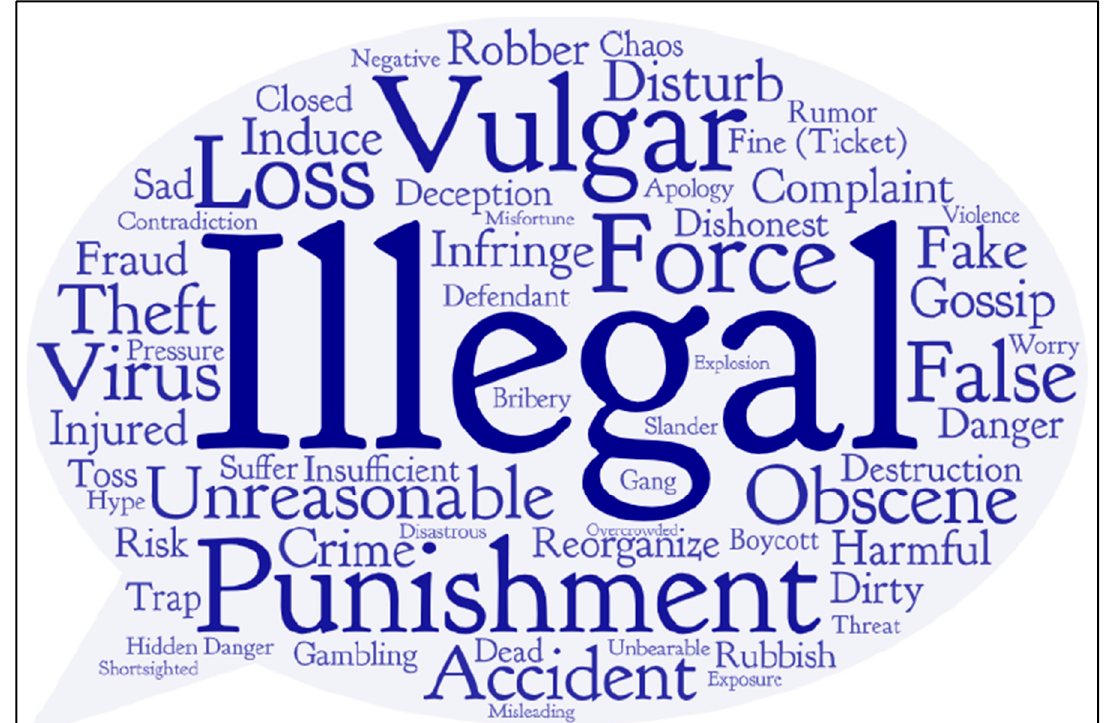
Figure 4. Keyword analysis of negative sentiment reviews.